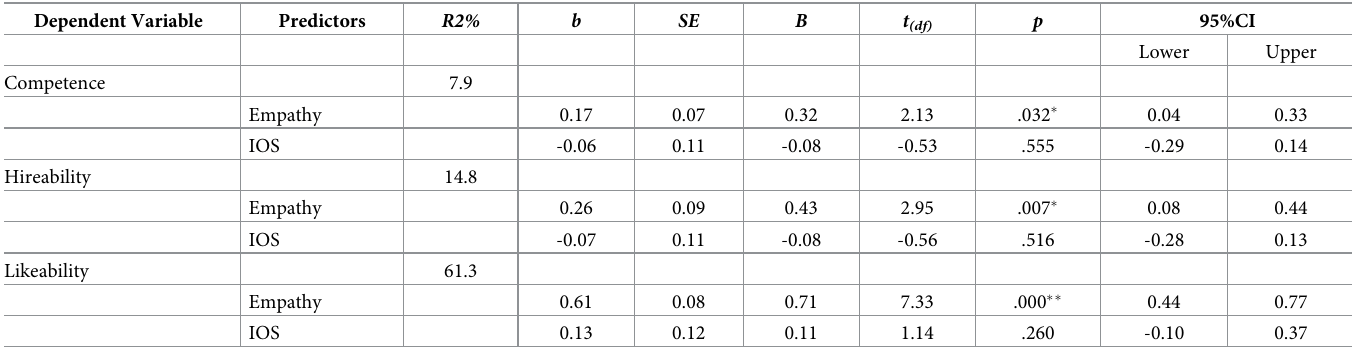
Table 6. Multiple regression models for the male